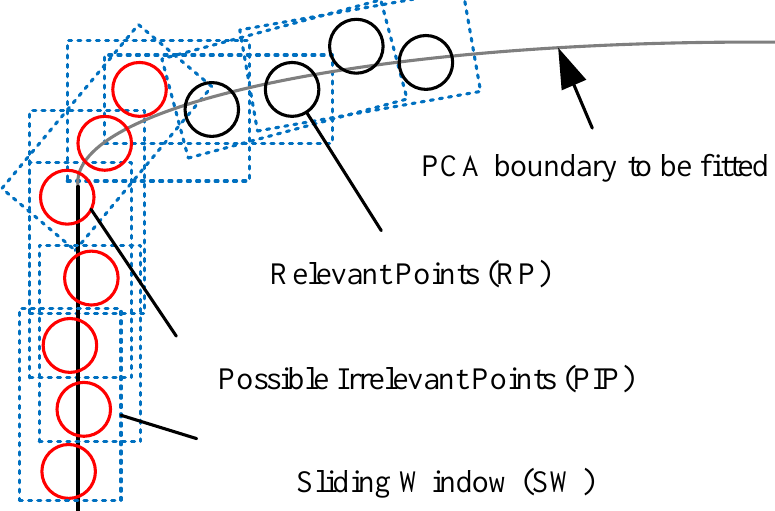
Figure 4. Sliding Window (SW) with a window size of three to detect Relevant Points